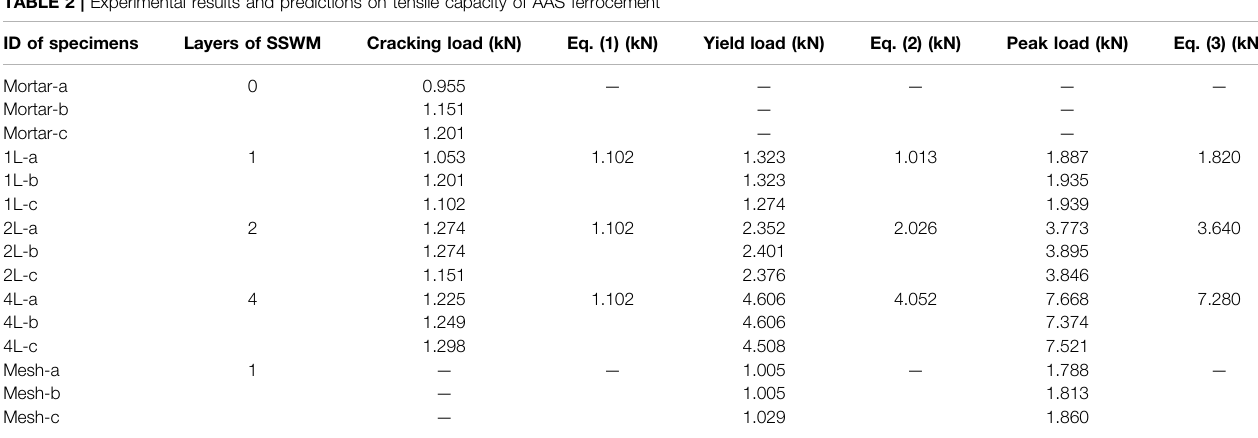
TABLE 2 | Experimental results and predictions on tensile capacity of AAS ferrocement ID of specimens Layers of